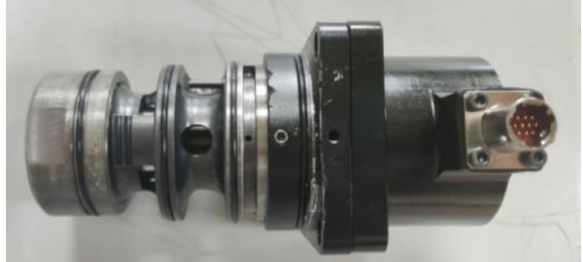
Figure 14. Physical diagram of the 2D electric feedback flow control